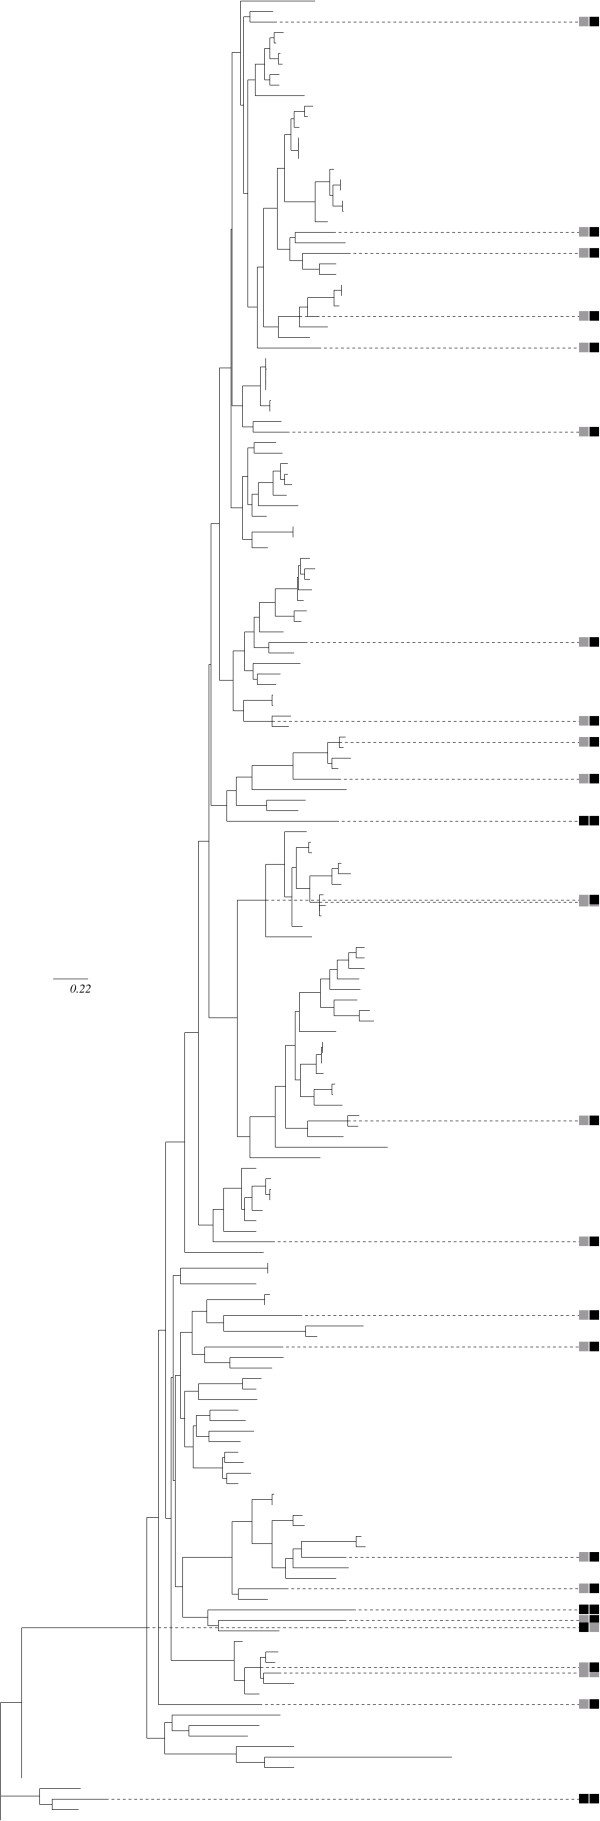
Weighted and signed charge substitution mapping for pair (GLN154, GLU158) of the MAP data set (see table 6). Only mappings for branches with at least one site with at least ± 0.9 substitution on average have been represented for clarity. Black squares indicate positive change (- → +), and gray squares indicate negative changes (+ → -).